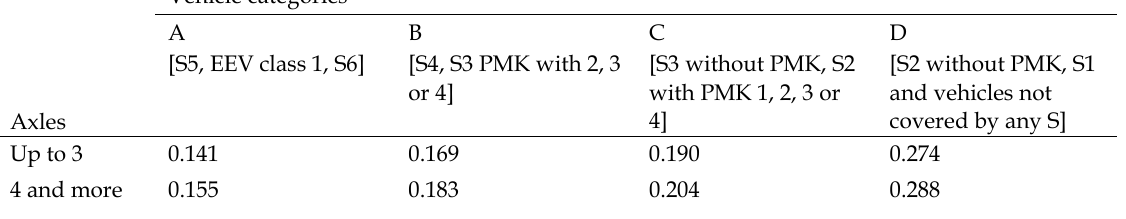
Table 1. HGV toll tariff structure in 2012 (in Euro per